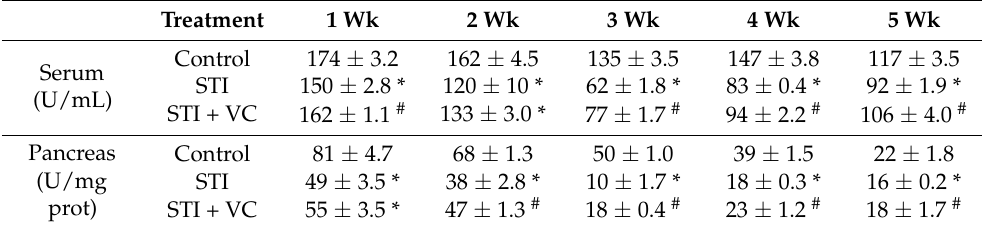
Table 5. SOD activity in serum and pancreas.